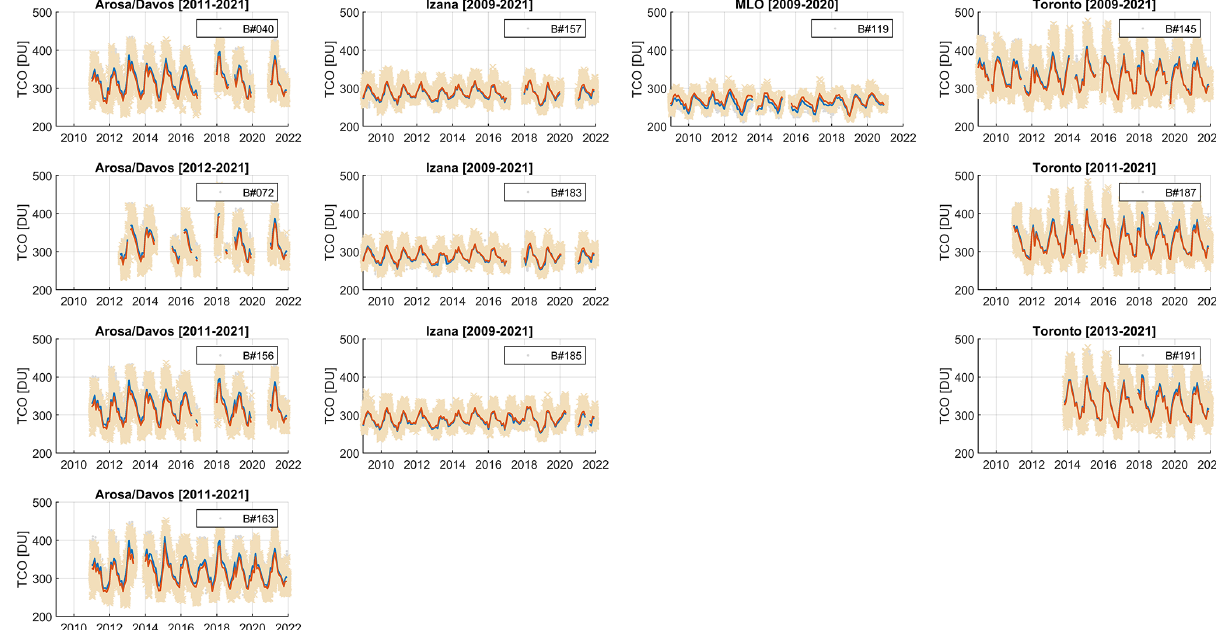
Figure A1. Time series of Brewer and MERRA-2 TCO. The red and blue lines are the monthly mean of Brewer and MERRA-2 TCO, respectively, and the shaded areas represent individual hourly values. The Brewer instrument numbers are given in the legend.